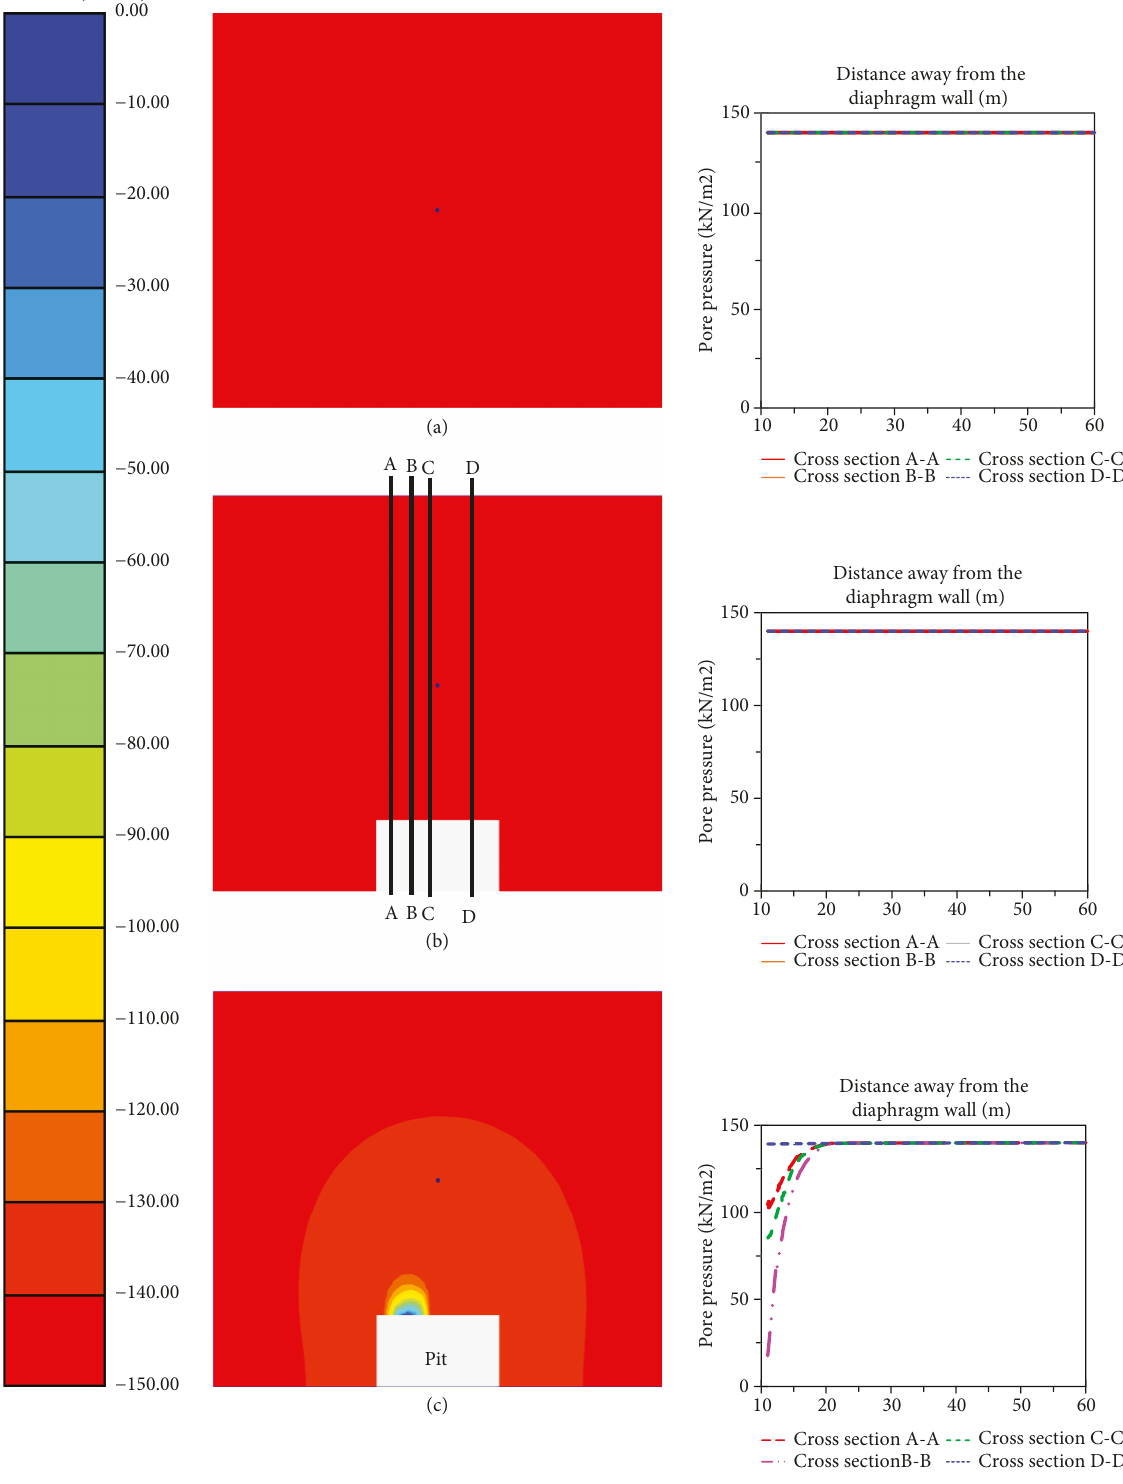
Figure 9: Change of pore pressure at various depths and locations at di ff erent phases of launching of a shield in plane view at 16mbgl. (a) Initial phase. (b) Main excavation. (c) Launching of the shield. Note: A-A: left side of tunnel eye; B-B: center of tunnel; C-C: right side of tunnel eye; and D-D: 5m away from the right side corner and “ - ” in pore pressure distribution contour is positive pore